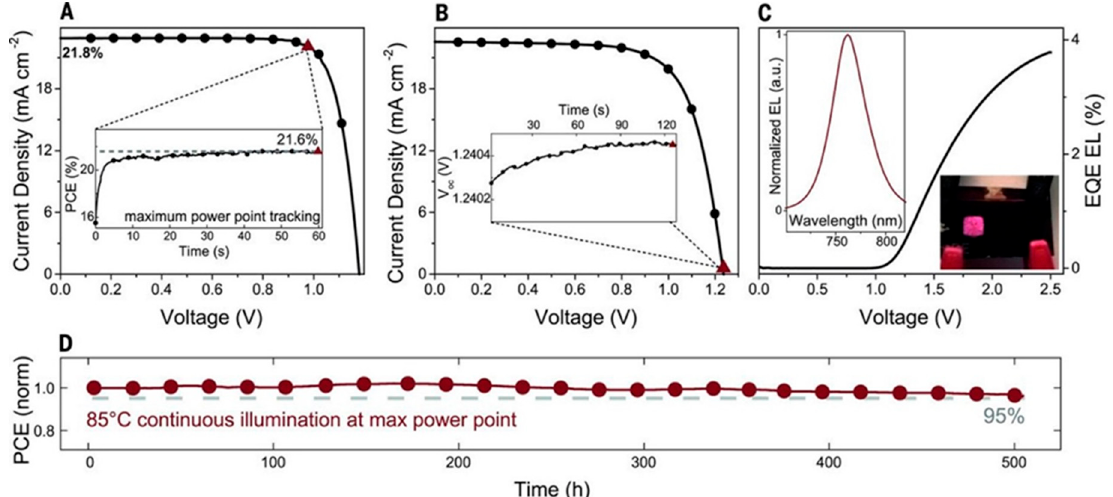
Figure 12. ( a ) Current density–voltage (J-V) curve of the highest performance RbCsMAFA solar cell. The inset shows the scan rate–independent maximum power point (MPP) tracking for 60 s. ( b ) J-V curve of the highest-V OC device. The inset illustrates the V OC for 120 s ( c ) EQE electroluminescence (EL) versus voltage. The left and right inset show the corresponding EL spectrum and two areas of a solar cell, respectively ( d ) Thermal stability as a function of time for the perovskite solar cell. Reprinted with permission from [103].